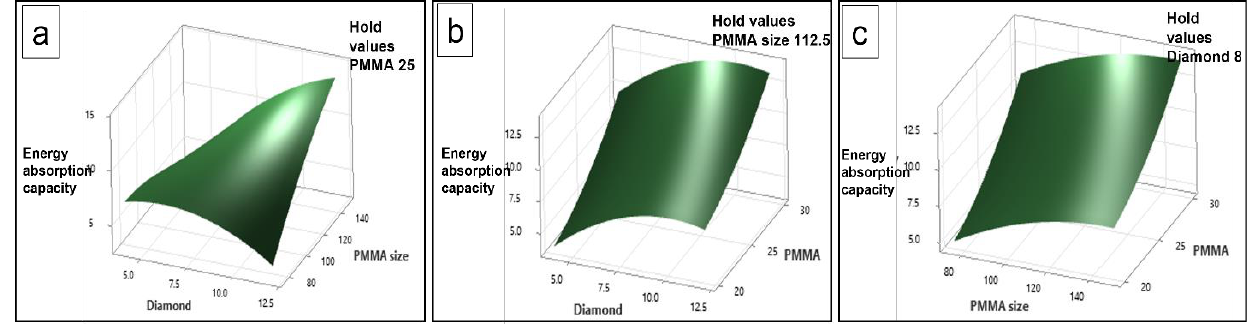
Figure 16. Surface plot of energy absorption capacity vs., ( a ) PMMA size, diamond content, ( b ) PMMA and diamond content, and ( c ) PMMA size, PMMA content.